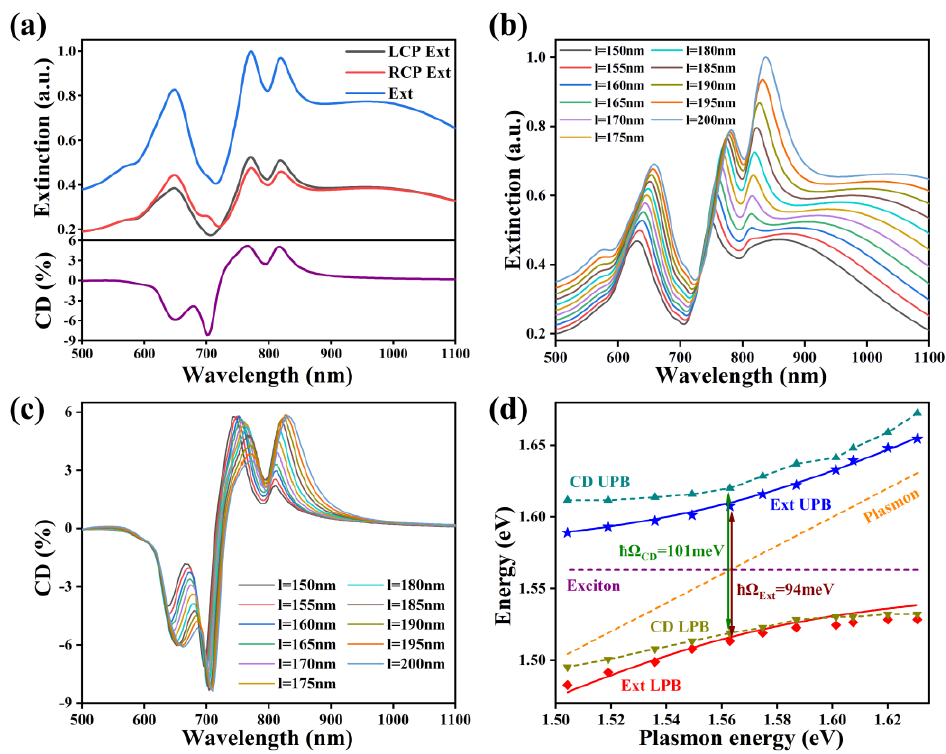
Figure 5. ( a ) The LCP extinction, the RCP extinction, the total extinction, and the CD spectrum of GHNP hybrid system at zero detuning. ( b ) Extinction and ( c ) CD spectra of the mixed mode–excitons strong coupling system with the detuning of side length l . ( d ) Dispersions of the hybrid modes extracted from the simulated extinction (blue stars, red diamonds) and CD (cyan positive triangles, yellow inverted triangles) spectra. The blue and red solid lines are fit results of the extinction data obtained via the COM. Rabi splitting of the anticrossing curves extracted from extinction and CD spectra are 94 meV and 101 meV, respectively. The purple and orange dashed lines represent uncoupled plasmon and exciton energies, respectively.